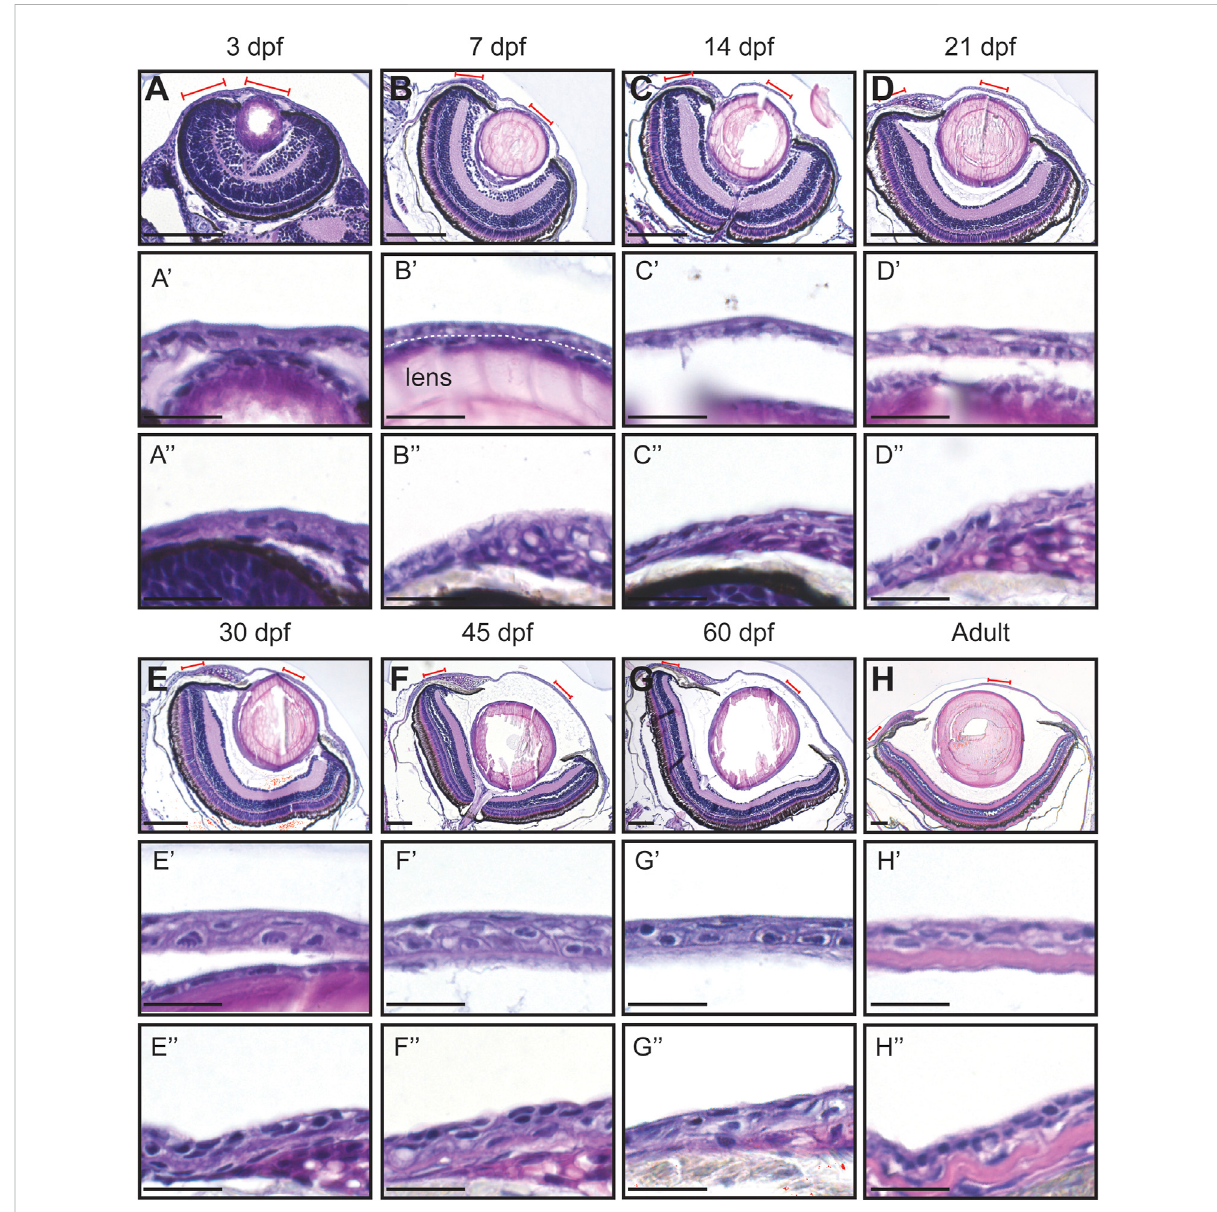
Hematoxylin-eosinstainingoftheeyein fi shofdifferentage(dpf,dayspost-fertilization). (A – H) Coronalsectionsoftheeye,anteriorsideonthe right.Redlinesindicatetheregionspresentedinhigher-magni fi cationimages.Whitedashedlinein (B 9 ) indicatestheborderbetweenthelensandthe cornea. (A ’– H ’ ) Cornea inthe central region. (A ’’– H ’’ ) Cornea inthe periphery/limbus. 3 samples per age group were checked. Scale bars: 100 µmin (A – H) , 20 µm in (A ’– H ’’ )